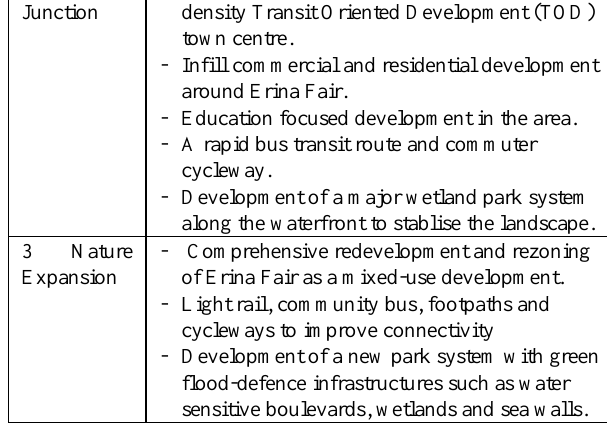
Table 3: Adaptation scenarios and strategies for Erina